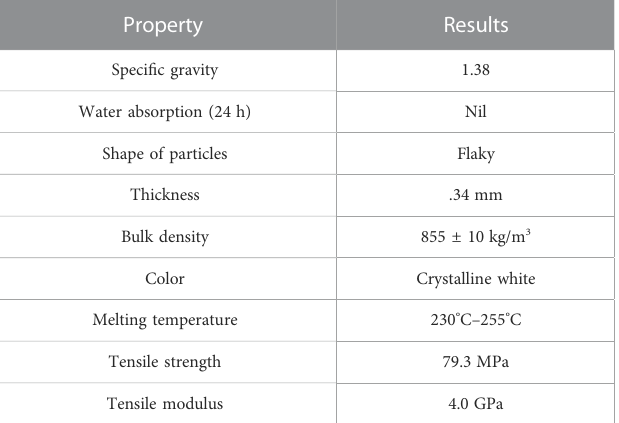
TABLE 3 “ Physical and mechanical characteristics of used PET ” Qaidi et al. (2022a).